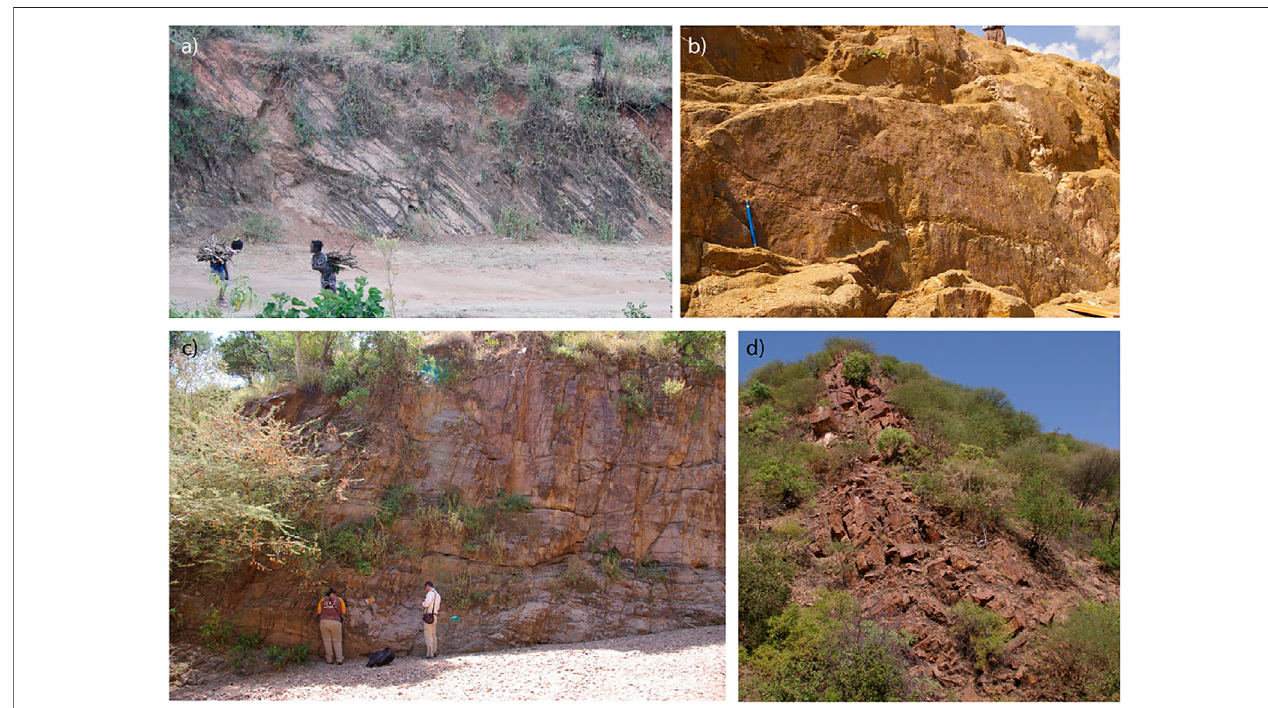
FIGURE 8 | Field examples of structures affecting the Precambrian basement in the southern MER: (A) magmatic foliation and (B) Cenozoic fault plane affecting basement and cutting quartz vein and aplitic dike in theGofa province; (C) System of subparallelfractures reactivated and associated to amajor normal fault (not visible of the left) in the Chew Bahir basin; (D) basement foliation sub parallel to the major fault plane delimiting the Chew Bahir basin.